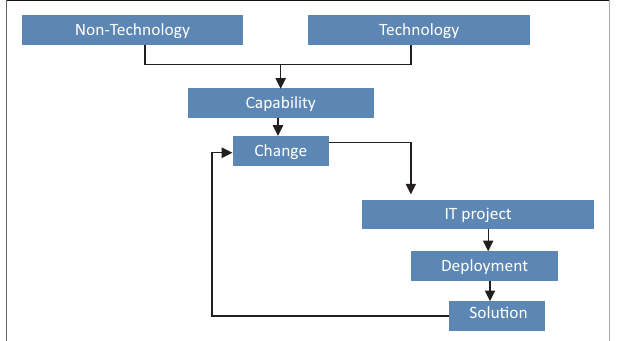
FIGURE 1: Information technology project